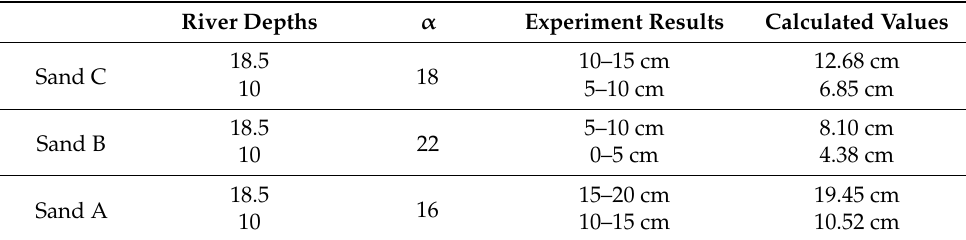
Table 3. Thicknesses of the inverted saturated zone calculated using a formula derived in the current